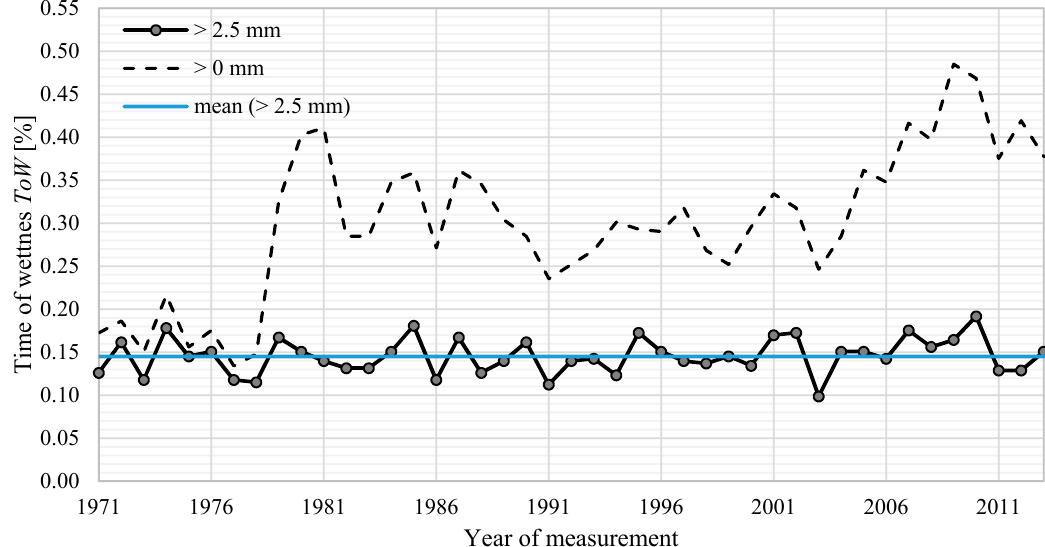
Figure 6. Time of wetness ToW for the weather station Gänsendorf, expressed in the percentage of number of rainy days.